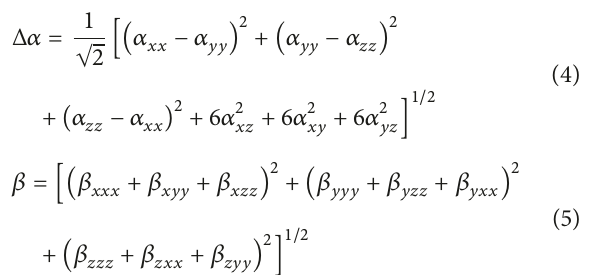
the theoretical and experimental results range from - 4.73